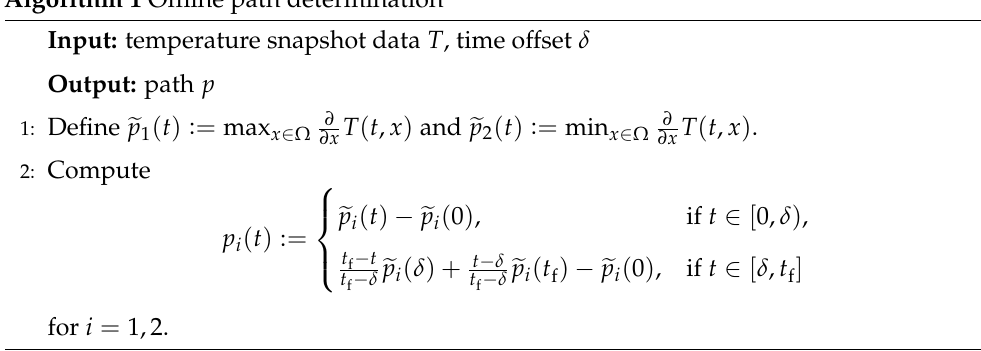
Algorithm 1 Offline path